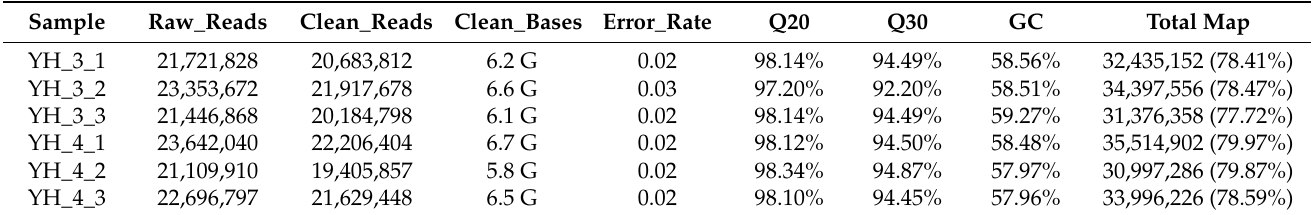
Table 1. Sample sequencing data quality summary and comparison statistics. YH_3_1–YH_3_3 refer to three replicates with municipal sewage; YH_4_1–YH_4_3 refer to three replicates with industrial heavy metal wastewater.